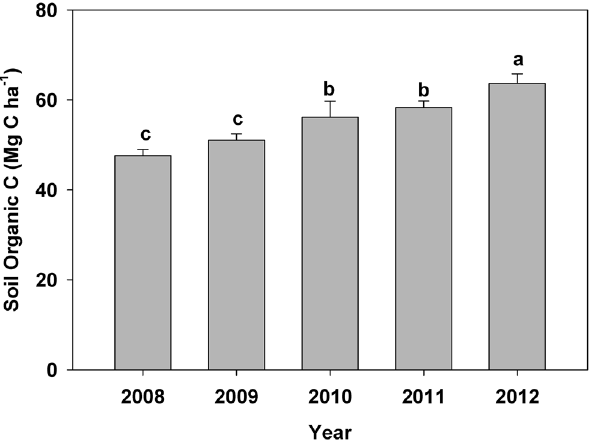
Fig. 1. Soil organic C variation with year in the upper 50 cm at College Station, Texas.